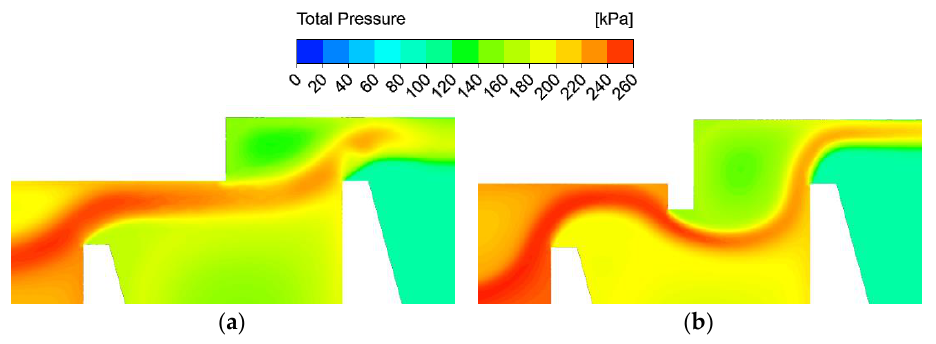
Figure 9. Total pressure plots for conventional seal and ribbed seal (PR = 2.5, S/H = 1.0, t/K = 0.1, β = 90°). ( a ) Conventional seal. ( b ) Ribbed seal.